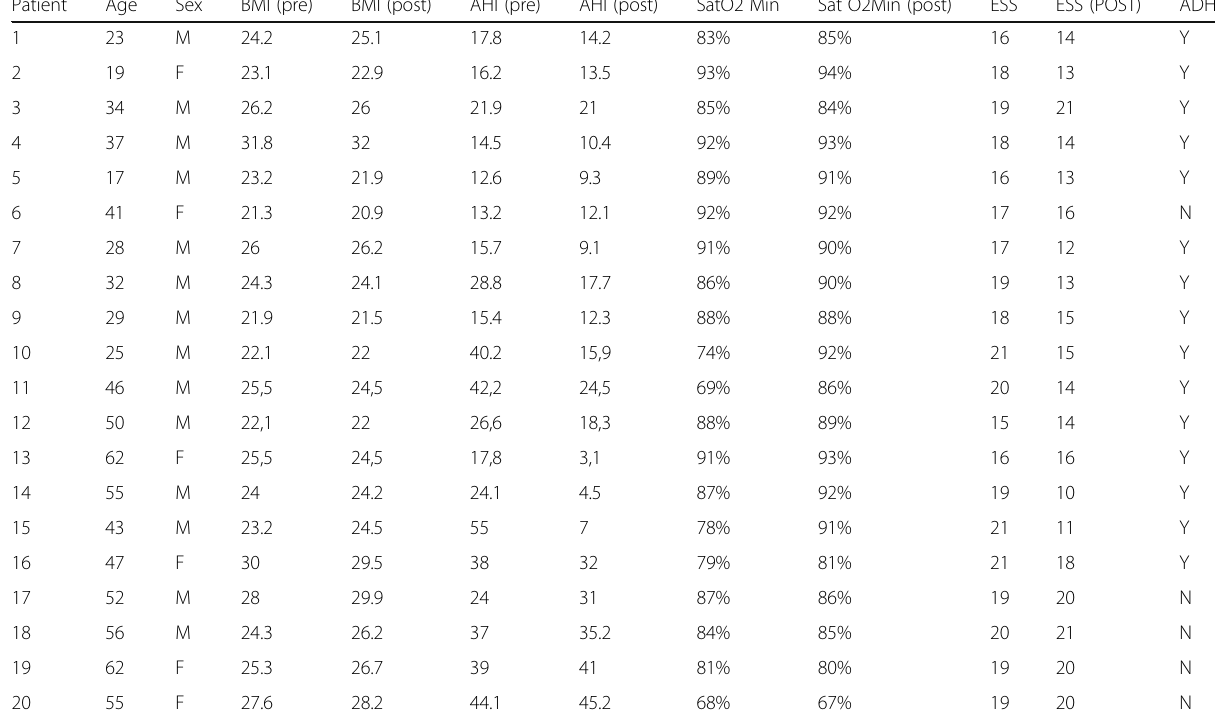
Table 1 All results obtained in both groups pre and post use the app Patient